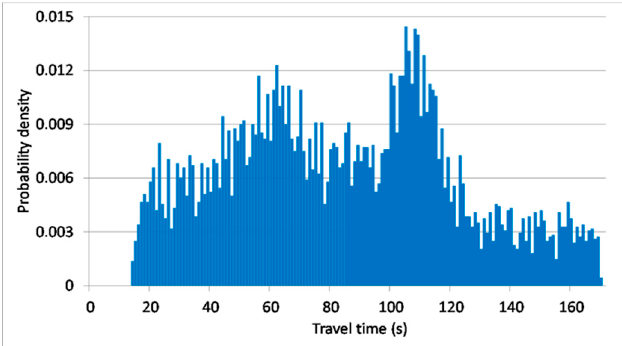
Figure 3. Distribution of simulation travel times.